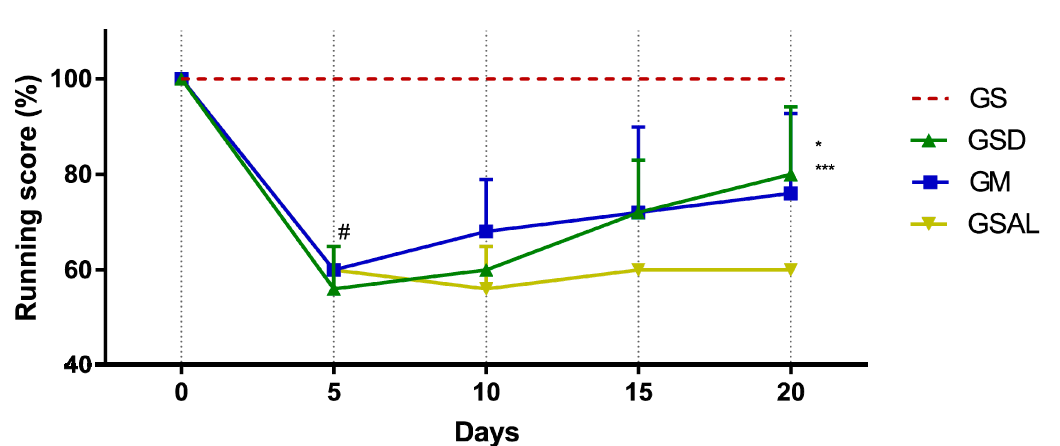
Figure 2. Effect of crude extract of S. dulcis on the evaluation of motor activity/forced ambulation using the Rotarod test. Results were expressed as mean ± standard mean error; # difference between GS and GSAL in D5 ( p ˂ 0.0001), GS and GSD in D5 ( p ˂ 0.0001), GS and GM in D5 ( p ˂ 0.0001); * difference between the GSD and GSAL in the D20 ( p = 0.0061); *** difference between GM and GSAL in the D20 ( p ˂ 0.0472), using 2-way ANOVA with the multiple comparisons test ( p < 0.05).